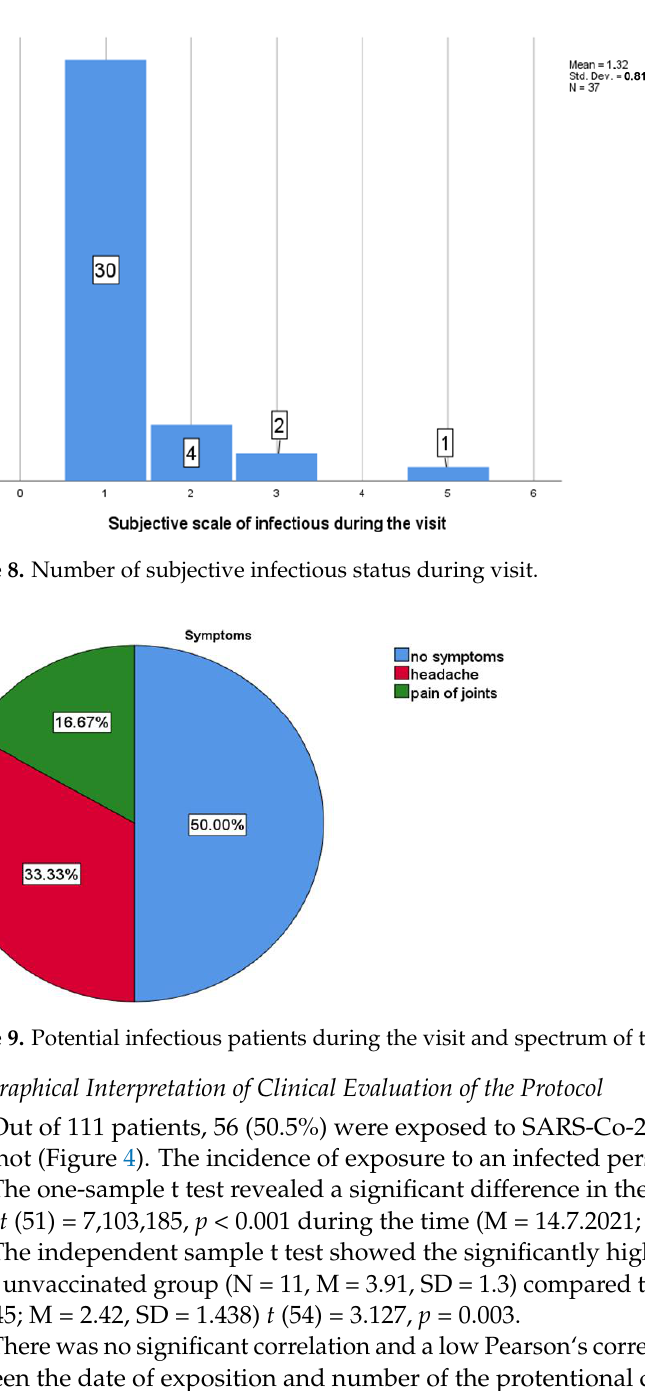
Figure 7. Biosafety feeling records by value.